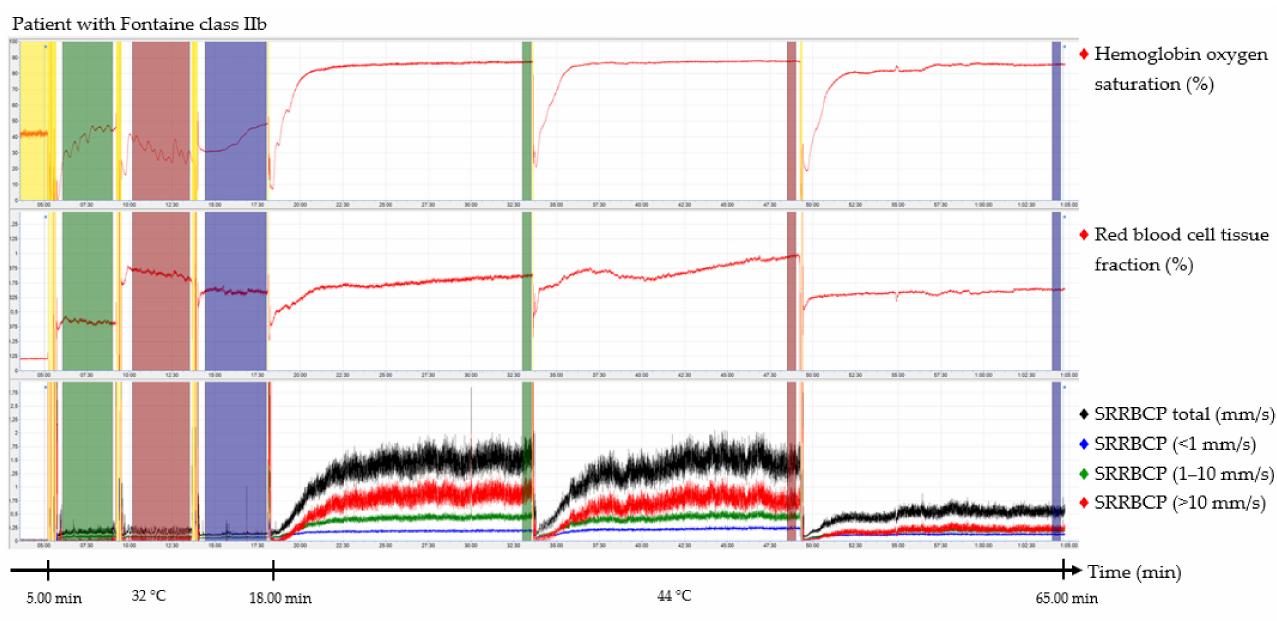
Figure 3. Continuous enhanced perfusion and oxygen saturation (EPOS) values of one patient with Fontaine class IIb. Green times of interest (TOIs) are measurements on the dorsal side of the foot. Red TOIs are measurements on the medial side of the foot. Blue TOIs are measurements on the calf. Yellow regions are motion artifacts. All participants rested at least 5 min before recordings started. SRRBCP: speed-resolved red blood cell perfusion.